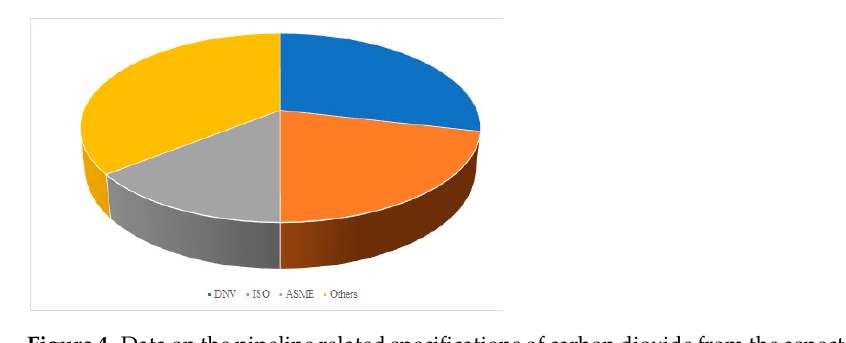
Figure 4. Data on the pipeline related specifications of carbon dioxide from the aspects of formulations and content.